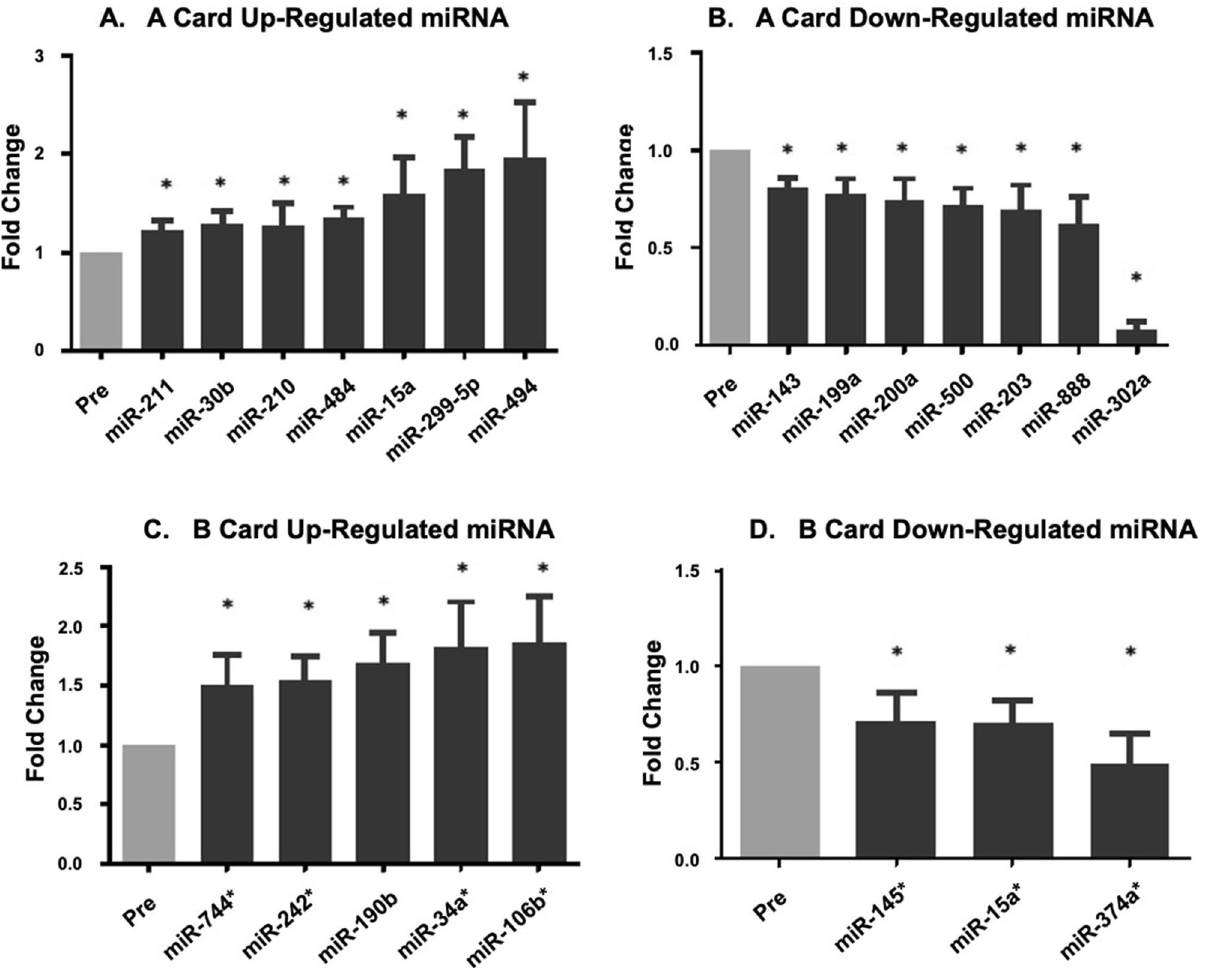
Figure 6. Differentially expressed miRNA at the post dry immersion time point. miRNA profiles were assessed only at the pre-DI and post-DI time points. This figure shows miRNA which were differentially expressed at the post-DI compared to pre-DI time point. All data are expressed mean ± SEM. Graph A shows miRNA that were up regulated after DI on the A card, and graph B shows miRNA that were downregulated after DI on the A card. Graph C shows B card up regulated miRNA, whilst graph D shows B card downregulated miRNA. * P < 0.05, Paired samples t-test and repeated measures ANOVA, n = 8 biological Platelet indices. The effects of DI on platelet indices were investigated as primary indicators of platelet phenotype, and also as surrogate markers of altered megakaryocytopoiesis (Fig. 2). There was an increase in platelet count (PLT) between PRE- DI to END- DI time points, probably reflecting the loss of plasma volume during the DI. There was a significant decrease in PLT between END- DI and RECOVERY- DI suggesting that platelet count returned to pre-immersion levels once subjects began to resume ambulatory activity. Navasiolava et al . found no significant difference in PLT after 7-days DI 22 . Other studies have indicated a significant increase in PLT after 7-day DI 39,40 . There were no changes in MPV, PDW or PLCR after three days of DI. There was a significant increase in plateletcrit from PRE- DI to END- DI and a significant decrease in plateletcrit from END- DI to RECOVERY- DI. Plateletcrit appears to be one of the more sensitive platelet indices markers. Overall, the combined increases in PLT and PCT observed at the time-point END- DI may indicate altered megakaryocy- topoiesis. Platelet function. The effect of PI on platelet function was quantified using the Impact R cone and plate analyser. We observed a significant increase in platelet adhesion from PRE- DI to END- DI suggesting stronger platelet-surface interactions in response to physical inactivity and DI. There was a significant decrease in SC% from END- DI to RECOVERY- DI indicating platelet adhesion levels had returned to their basal state. There was a significant increase in AS from PRE- DI to END- DI suggesting that PI/DI results in elevated platelet aggrega- tion with increased activation of GPαIIbβ3 and increased affinity for fibrinogen binding. Platelet aggregation decreased slightly from END- DI to RECOVERY- DI. The reduction in blood volume as a consequence of reduced total body water in the body during microgravity has been suggested as a factor for thrombotic tendencies, which could have been a determinant of increased platelet activation in this study 50 .